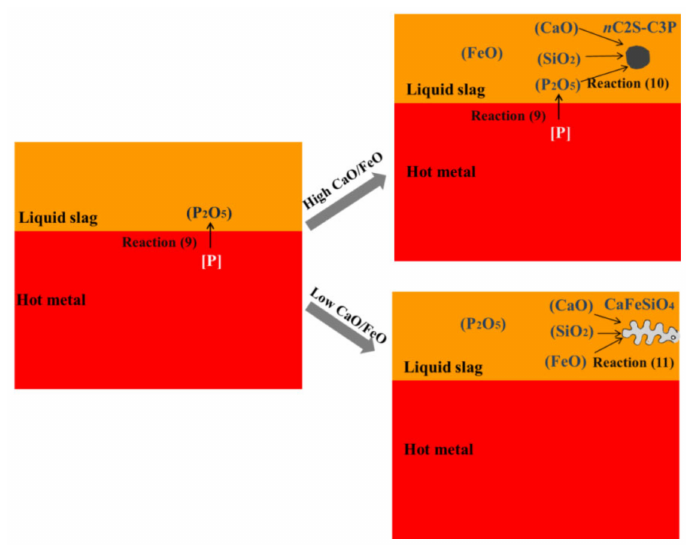
Figure 13. Interaction mechanism between the slag and hot metal for